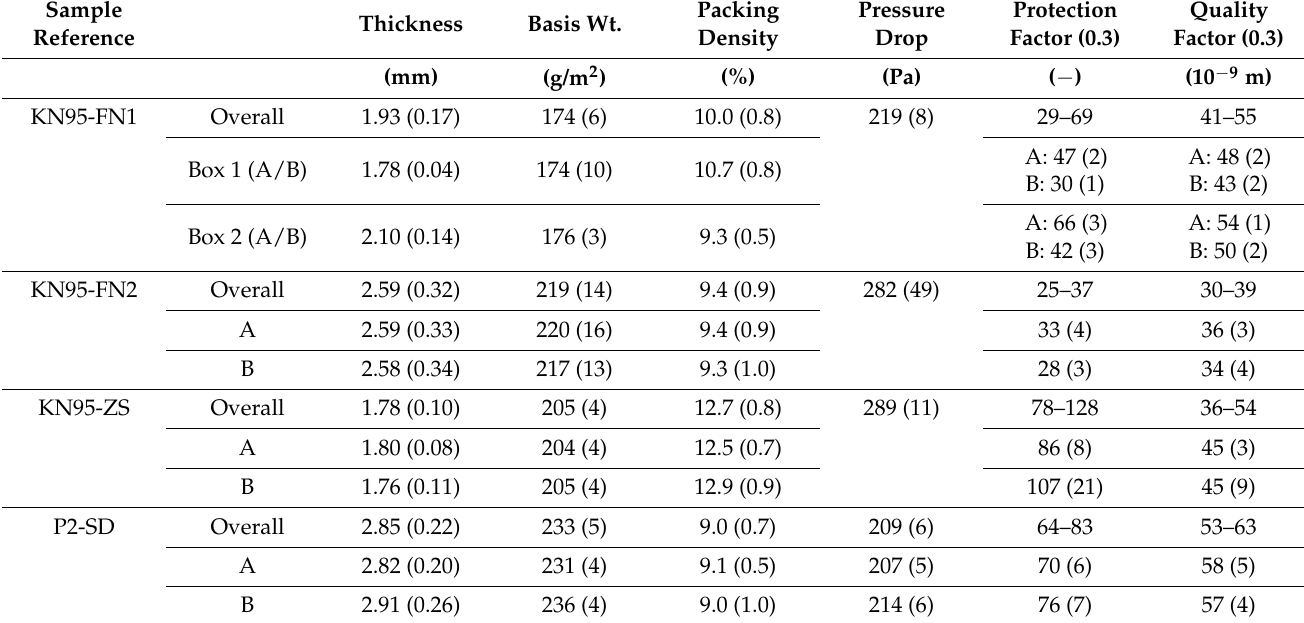
Table 2. Filter material specifications, and properties (standard deviations in